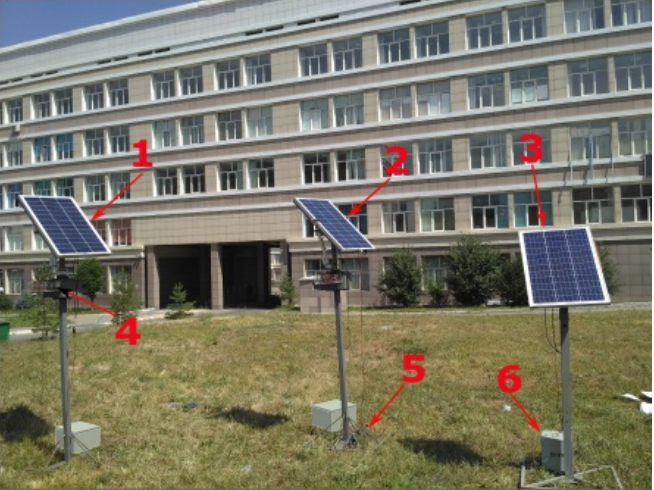
Figure 9. Experimental installations.